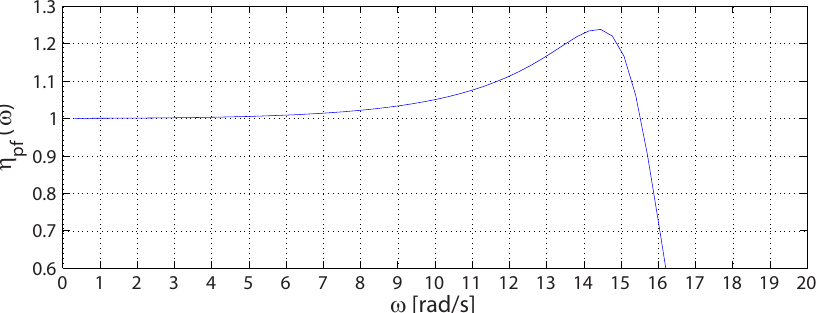
Figure 10. Curve of absolute stability with the parameter values defined in Subsection III-C, but with the proportional gain k m of the master position controller set to 20% of the actual